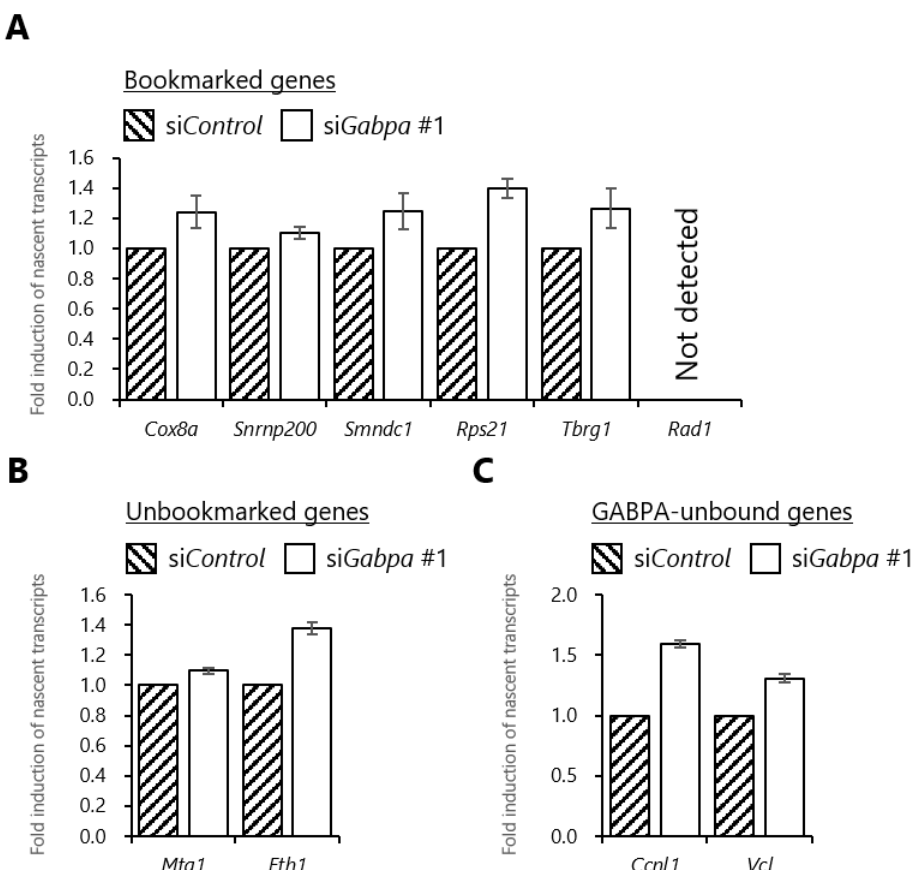
Figure 5. Gabpa knockdown increases transcriptional induction at the early G1 phase. ( A , B ) Relative nascent transcriptional induction after release from mitotic synchronization in Gabpa knockdown cells. tsFT210 cells transfected with siRNA against Gabpa or negative control siRNA were arrested in